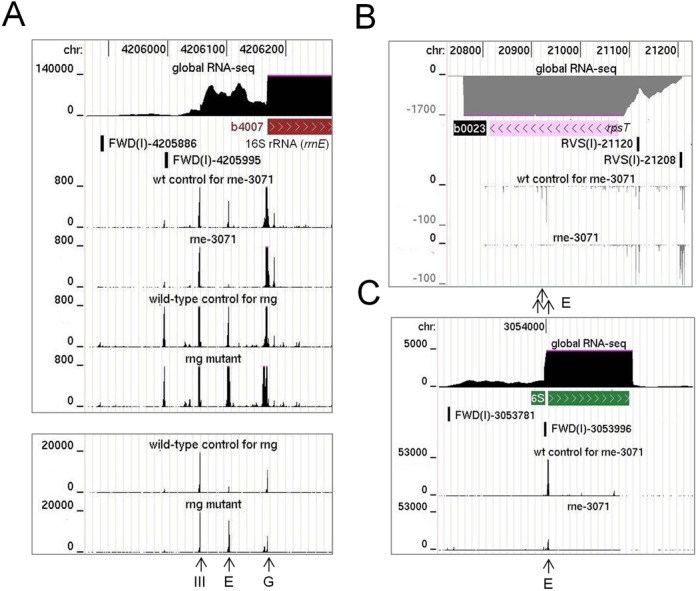
RNA-seq profiles at well-documented sites of RNase E cleavage. (A), (B) and (C) show the profiles for sites at the 5′ end of 16S rRNA, within the coding region of rpsT mRNA and at the 5′ end of 6S RNA, respectively. In each panel, the top three tracks show the positions of the corresponding gene with the transcriptome (global RNA-seq) above and the transcription start site mapping data below for a WT strain of Escherichia coli grown under similar conditions (Romero et al., submitted). The tracks below show the reads obtained at each position in a mutant and its congenic WT partner. The strains are identified by labels above each track. Numbers on the left indicate the scale of the sequencing reads, while numbers at the top indicate the genome position. Data for the disruption of RNase G is shown using two different scales in (A). The panels are modified screenshots from the UCSC Microbial Genome Browser (40). Vertical arrows at the bottom of each panel identify sites of cleavage by RNase III, E and G.